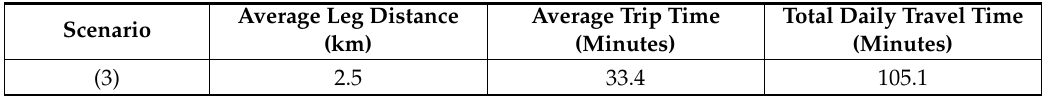
Table 4. Mobility indicators of the travelers in scenario (3).